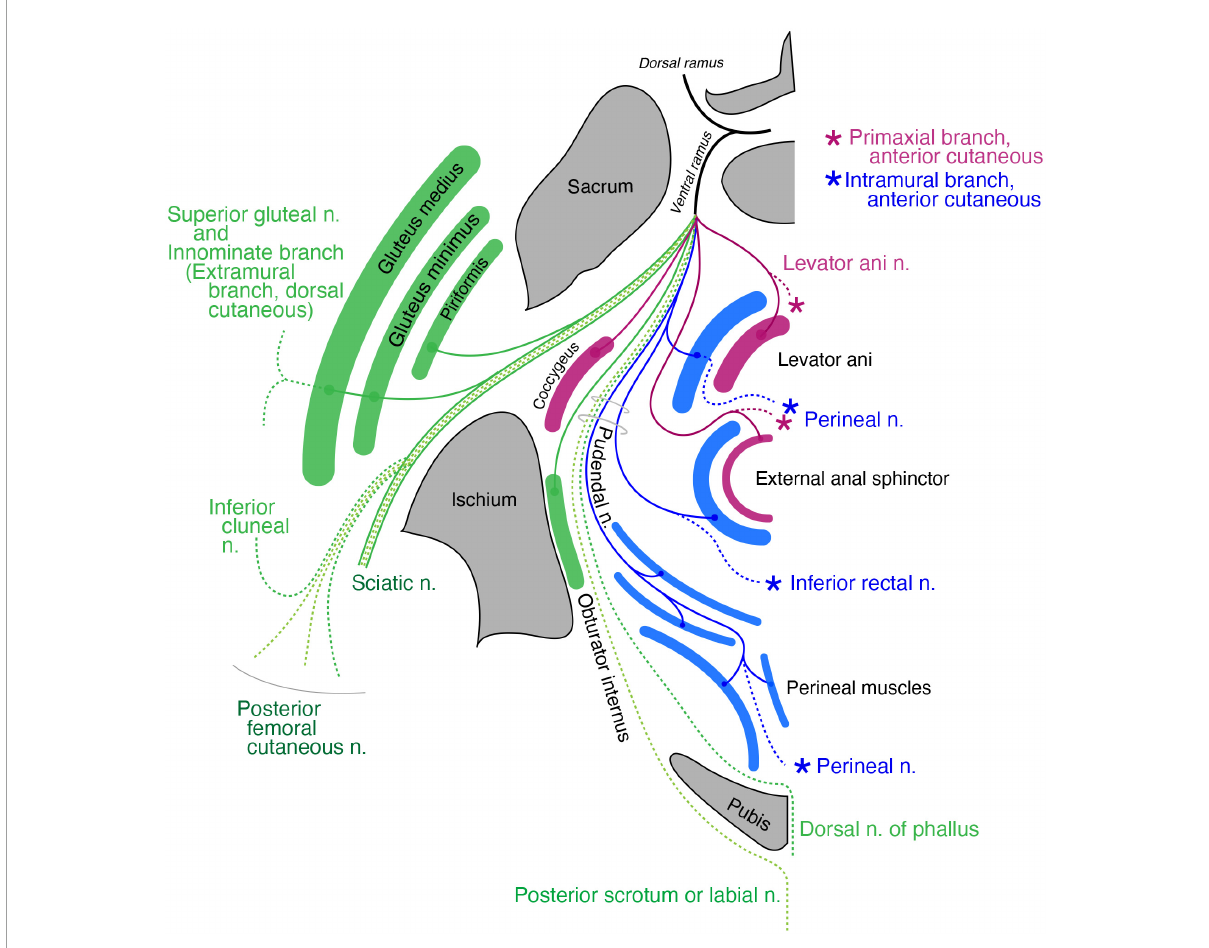
FIGURE11 Schematic illustration of the innervation pattern in the pelvic region. The superior gluteal nerve (dark green branch) innervates the gluteus medius and minimus, and its cutaneous extension is innominate (dashed lines). The levator ani muscle, including the primaxial (purple) and abaxial (blue) parts, are differentially innervated by the primaxial (purple) and abaxial (blue) anterior branches, respectively. Similarly, the subcutaneous part of the external anal sphincter (purple) is innervated by the anterior primaxial branch (purple). The anterior abaxial branch (blue, the inferior rectal nerve) innervates the rest of the external anal sphincter muscle (blue). The muscles associated with the perineal membrane are innervated by the pudendal nerve (perineal nerve, blue). The sciatic nerve is the extramural branch (dark green). The inferior cluneal nerve corresponds to the dorsal extramural cutaneous branch (dark green). The dorsal nerve of the phallus is a homolog to the ventral extramural cutaneous nerve (dark green). The posterior femoral cutaneous and posterior scrotal/labial nerves are equivalent to the LCB (light